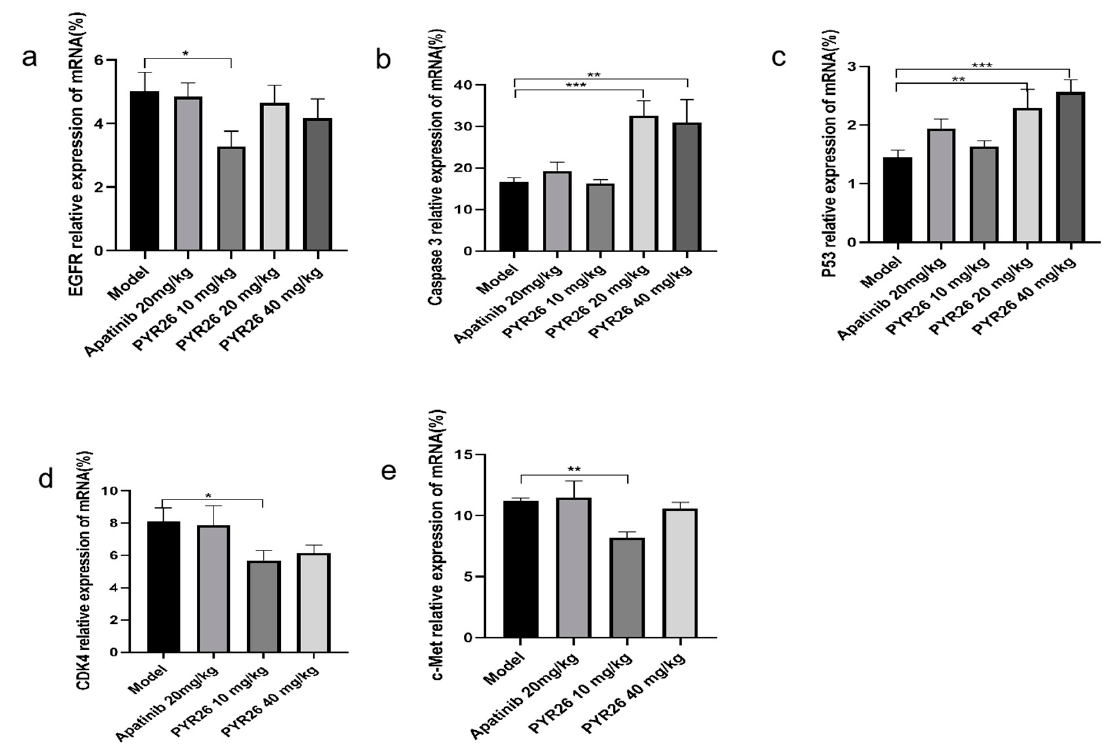
Figure 9. Expression of EGFR, caspase-3, p53, CDK4 and c-Met genes in nude mice after 14 days of PYR26 administration (* p < 0.05, ** p < 0.01, *** p < 0.001 vs. control group).